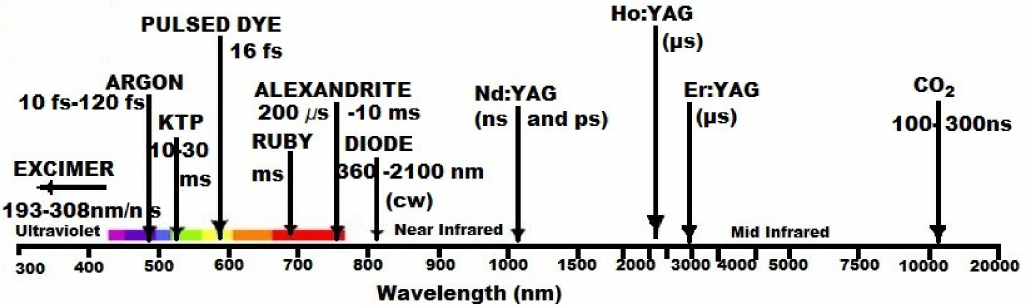
Figure 4. Types of lasers with applications in